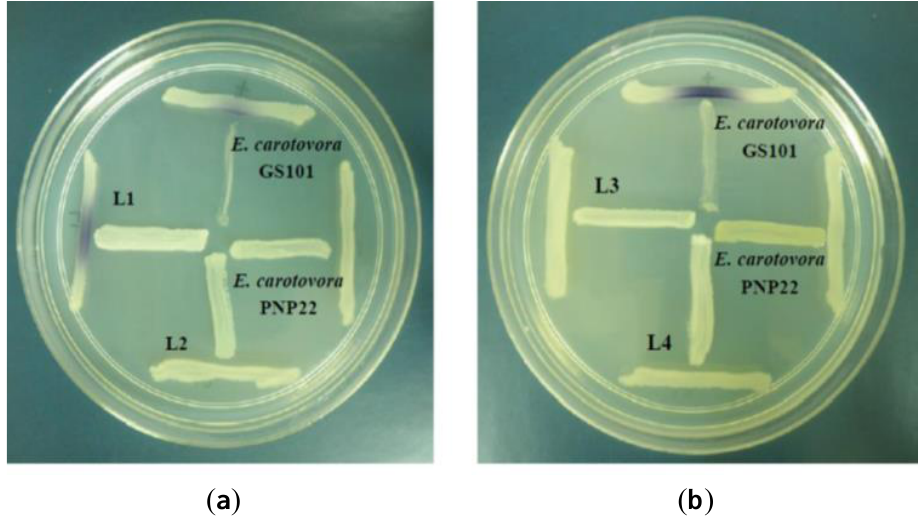
Figure 2. Screening for violacein production using C . violaceum CV026 cross streaking. E . carotovora GS101 and E. carotovora PNP22 were used as positive and negative controls, respectively. ( a ) Observation of purple pigment formation on the biosensor streak line indicates the production of exogenous short chained AHL molecules by the E . asburiae (L1) isolate; negative purple pigmentation for L2 isolate and ( b ) both L3 and L4 isolates indicate no AHL production from these isolates.